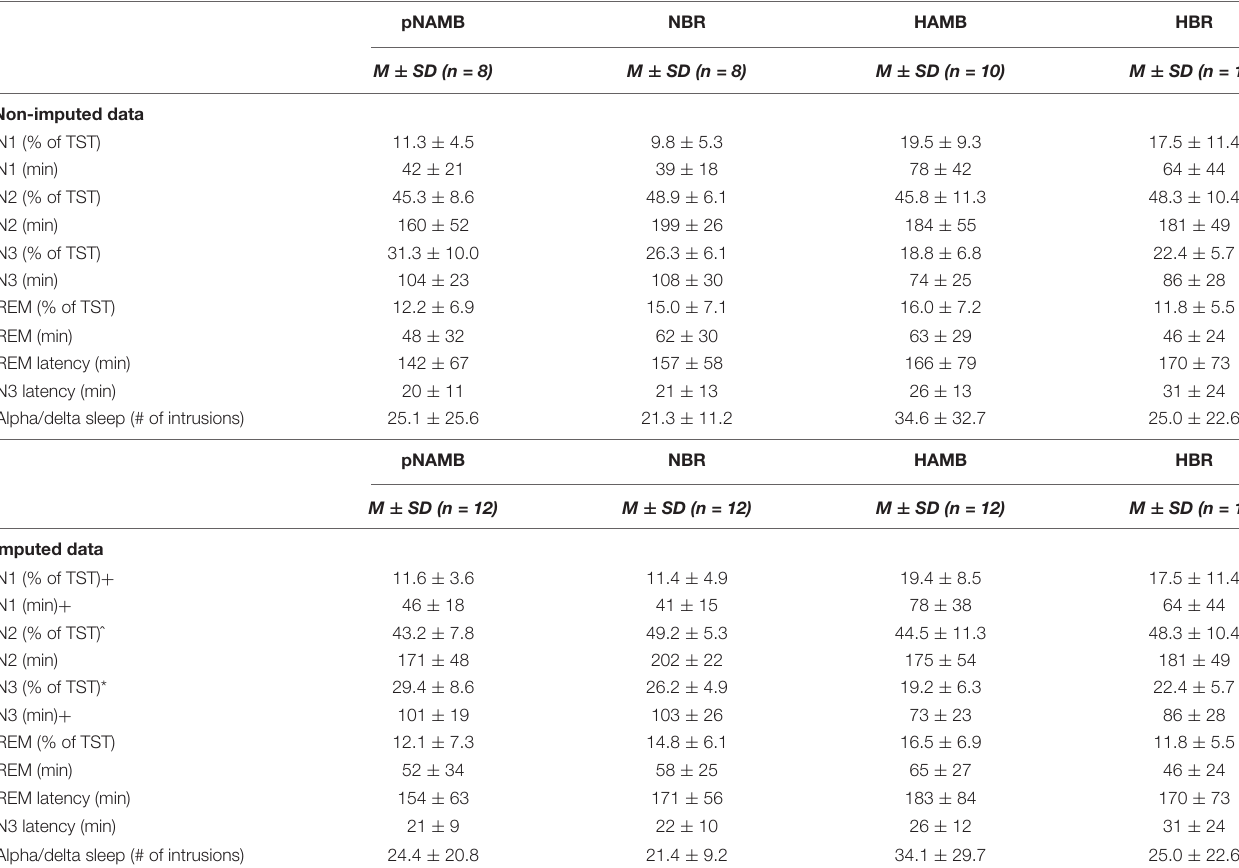
TABLE 2 | Overview of sleep architecture outcomes in each level of both independent variables (i.e., activity and PO 2 ). pNAMB NBR HAMB